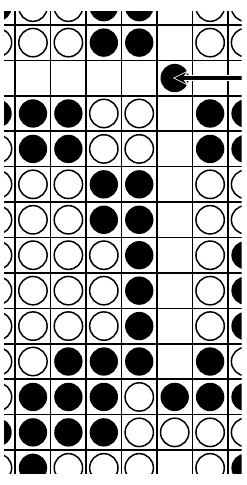
Figure 76. BLACK protects it. BLACK’s invasion of the checkmating square forces his defeat in Figures 77–80 inside the focus B.